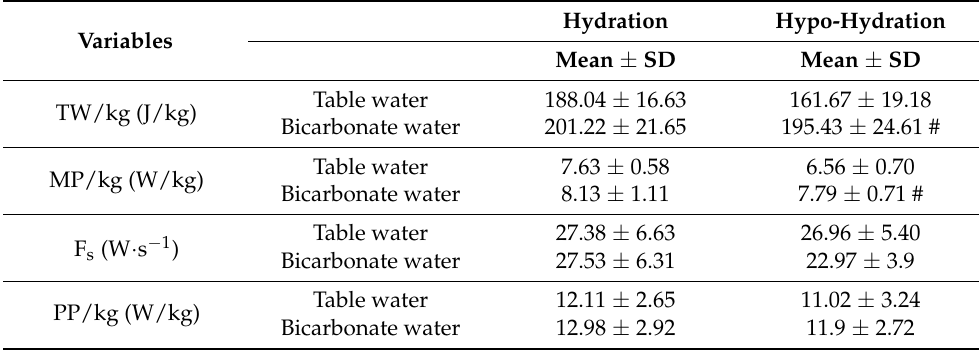
Table 3. The differences in anaerobic performance variables—upper limbs, after table water, and bicarbonate-rich water